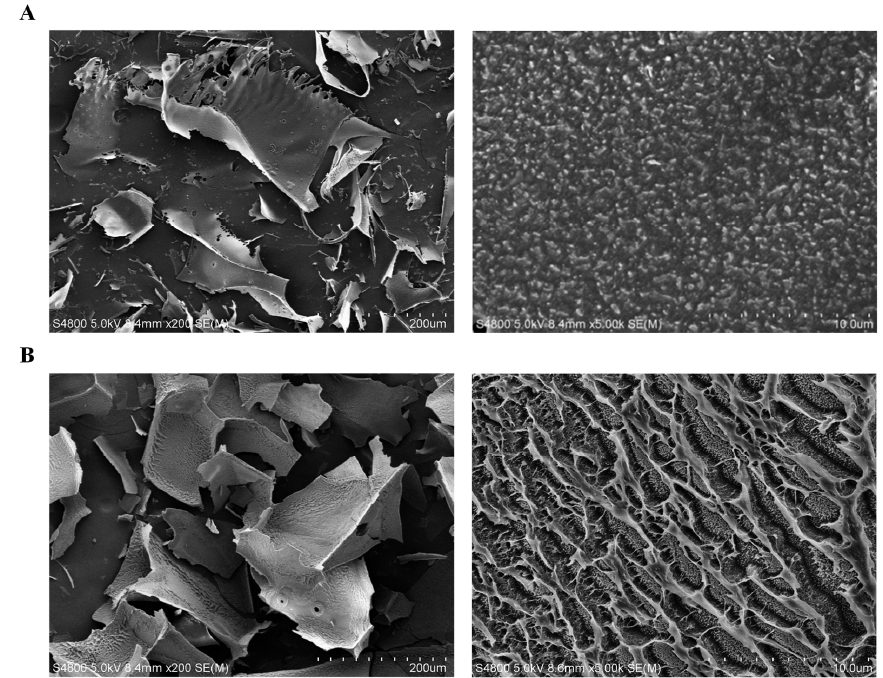
Figure 6. Scanning electron micrograph analysis. ( A ) S1, × 200 (left); ×5000 (right), ( B ) S2, × 200 (left); ×5000 (right).